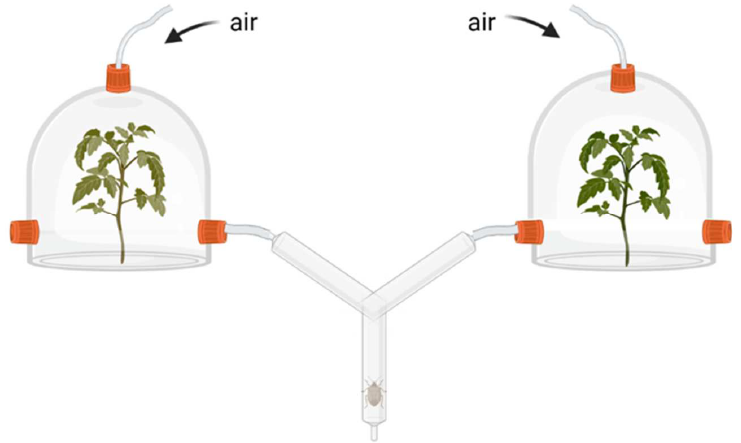
Figure 4. Schematic representation of the Y-tube olfactometer used in the behavioral assays with the predators.